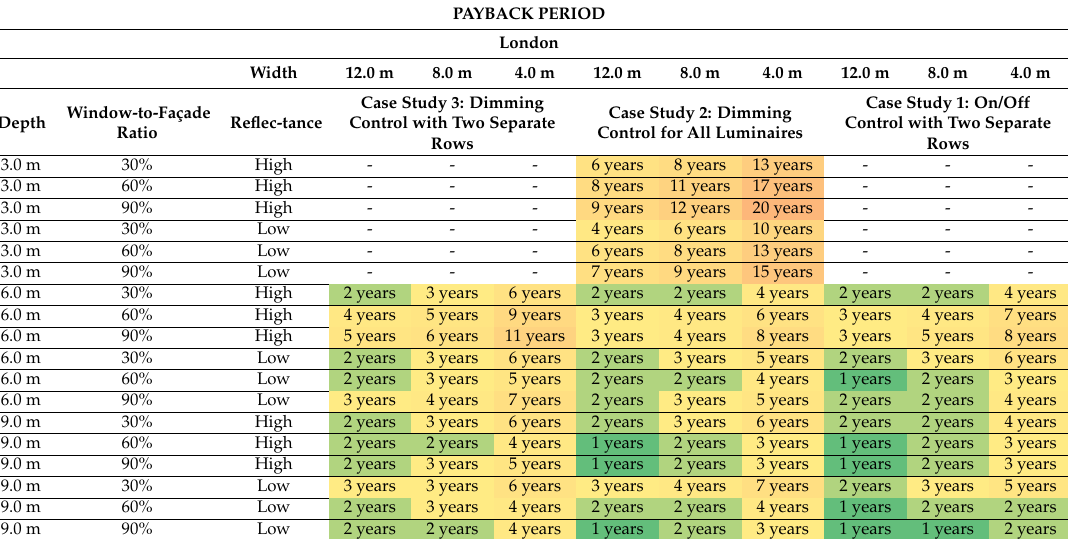
Table 14. Payback period according to different lighting smart controls in